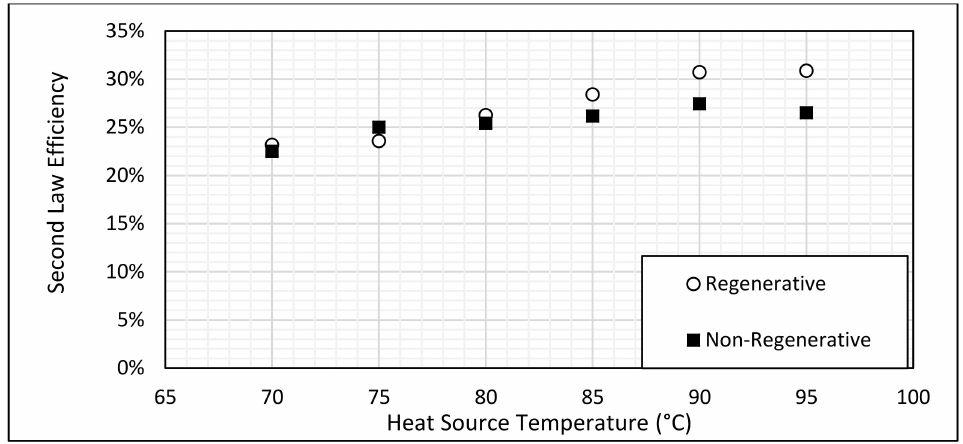
Figure 13. Variation in second-law e ffi ciency of the cycle with changing heat source temperature.